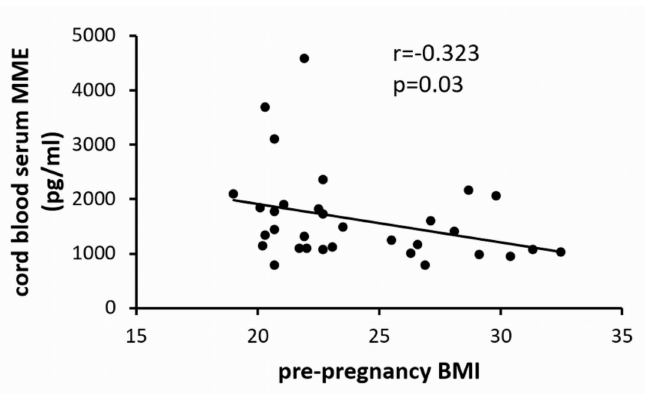
Figure 3. Correlation of umbilical cord blood serum MME levels with maternal pre-pregnancy BMI ( n = 32). This opposes findings in adults demonstrating upregulation of circulating MME with increasing BMI [13,14]. We therefore investigated whether the reduction of MME in cord blood serum is determined not by maternal BMI, but by fetal weight. However, similar to maternal BMI, neonatal weight also correlated negatively with cord blood MME (Figure 4).